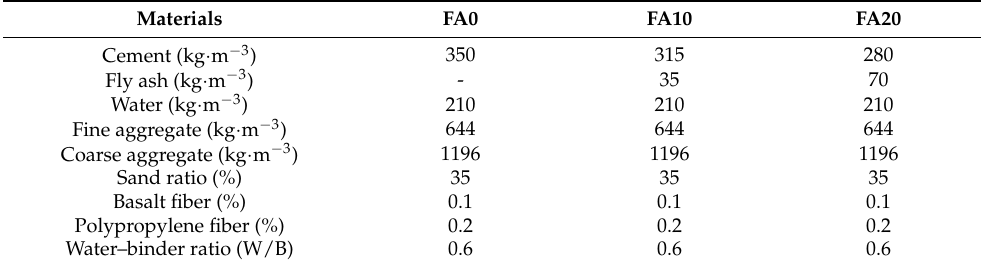
Table 3. Mix proportions of